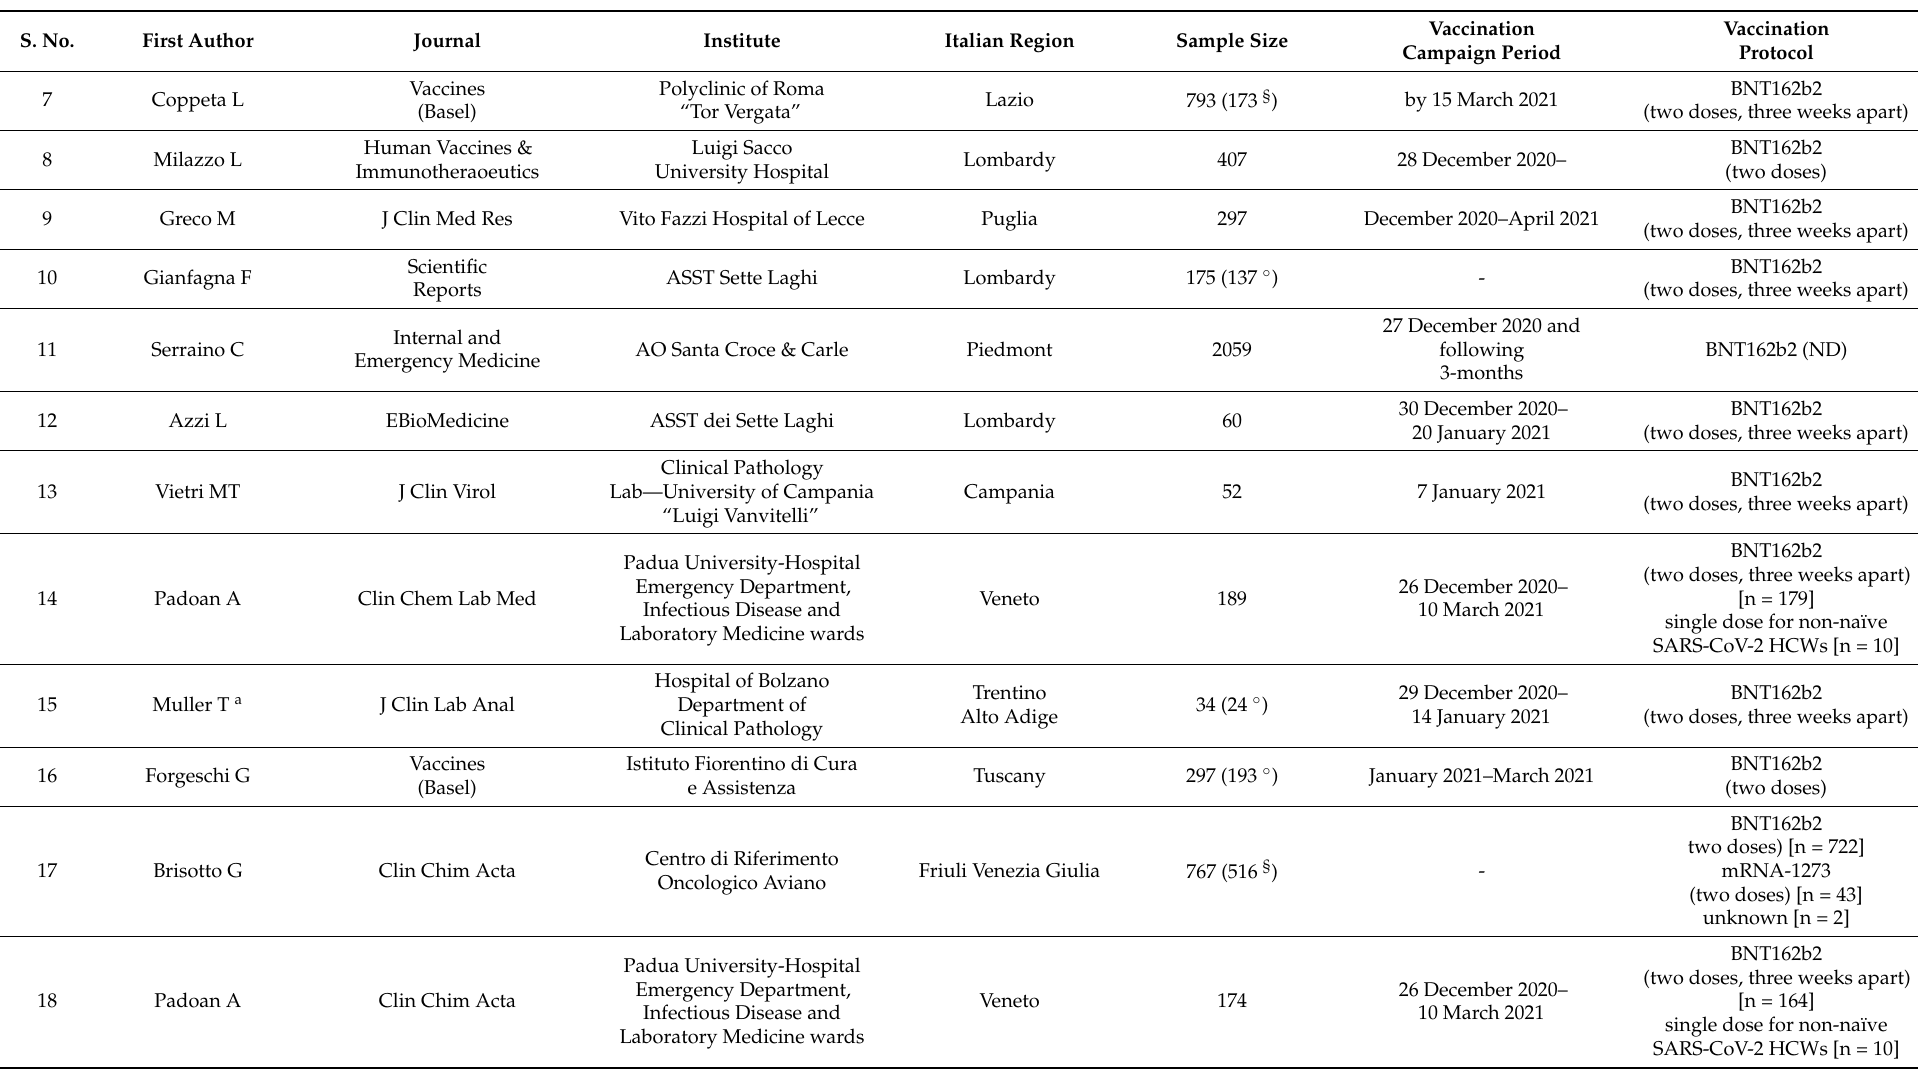
Table 1. Source on publication and study